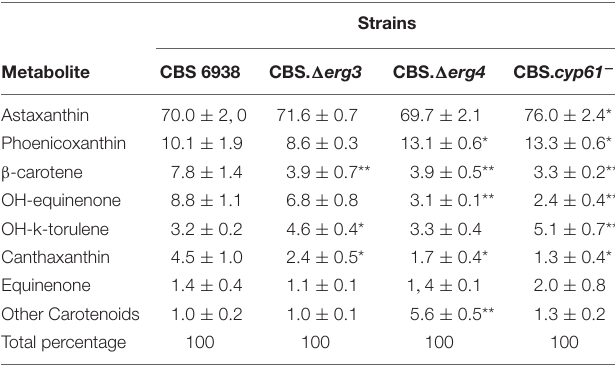
TABLE 3 | Composition (in %) of carotenoids of the mutant and parental strains of X. dendrorhous analyzed by RP-HPLC.